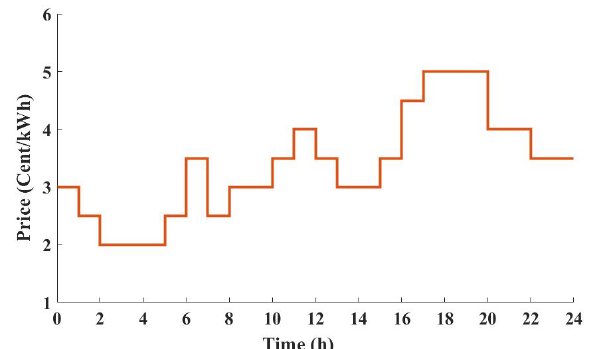
Figure 2. Day ahead electricity price